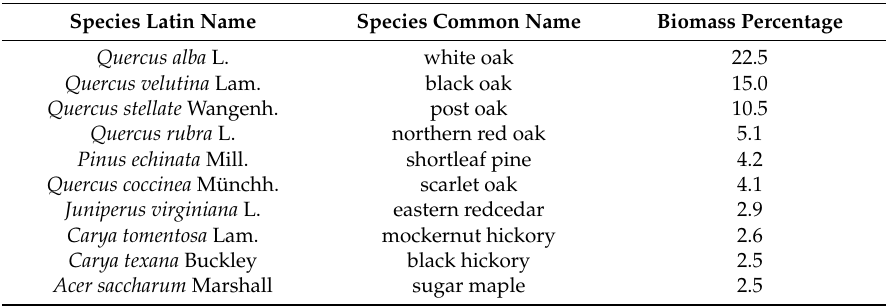
Table 1. The top ten most abundant species in the Ozark Highlands ecological section by percentage of total aboveground biomass as reported by the U.S. Forest Service Forest Inventory and Analysis estimate from plots sampled between the years 2011–2015.